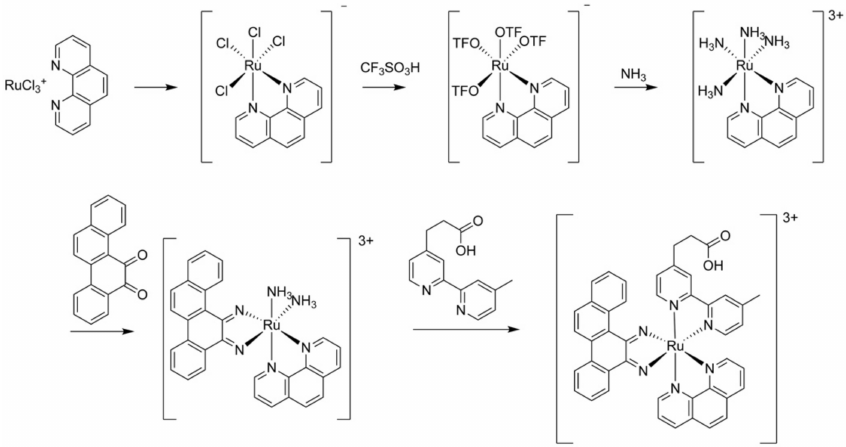
Scheme 2. Simplified synthesis of the modified ruthenium complex, according to reference